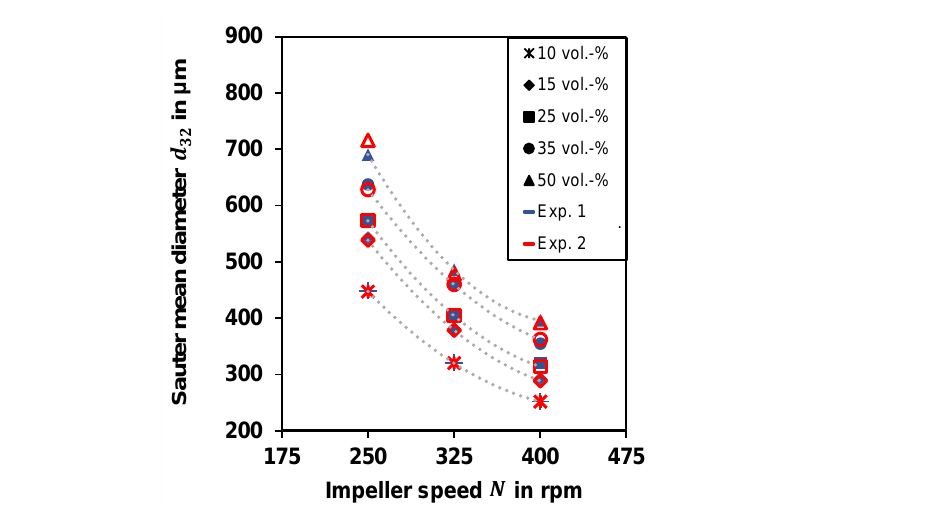
Figure 6. Experimental Sauter mean diameter (experiment 1: blue solid symbols, repetition experiment 2: red hollow symbols) at different rpm and phase fractions (dotted lines are a guide to the eye).